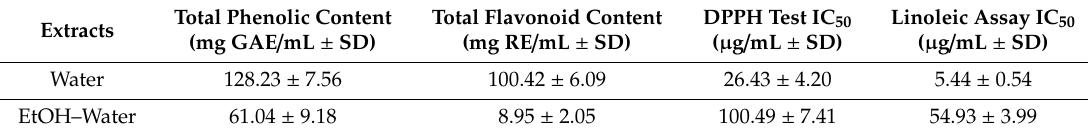
Figure 2. Qualitative mass spectrometry (MS) analysis of C. minima extracts yielding gallic acid and resveratrol signals at mass-to-charge ratio ( m / z ) 169 and 227, respectively. Data were confirmed by comparison with gallic acid and resveratrol MS spectra collected by MassBank Europe (https://massbank.eu/MassBank/). ( A ) MS spectrum of C. minima water extract. ( B ) MS spectrum of the C. minima hydroalcoholic extract.